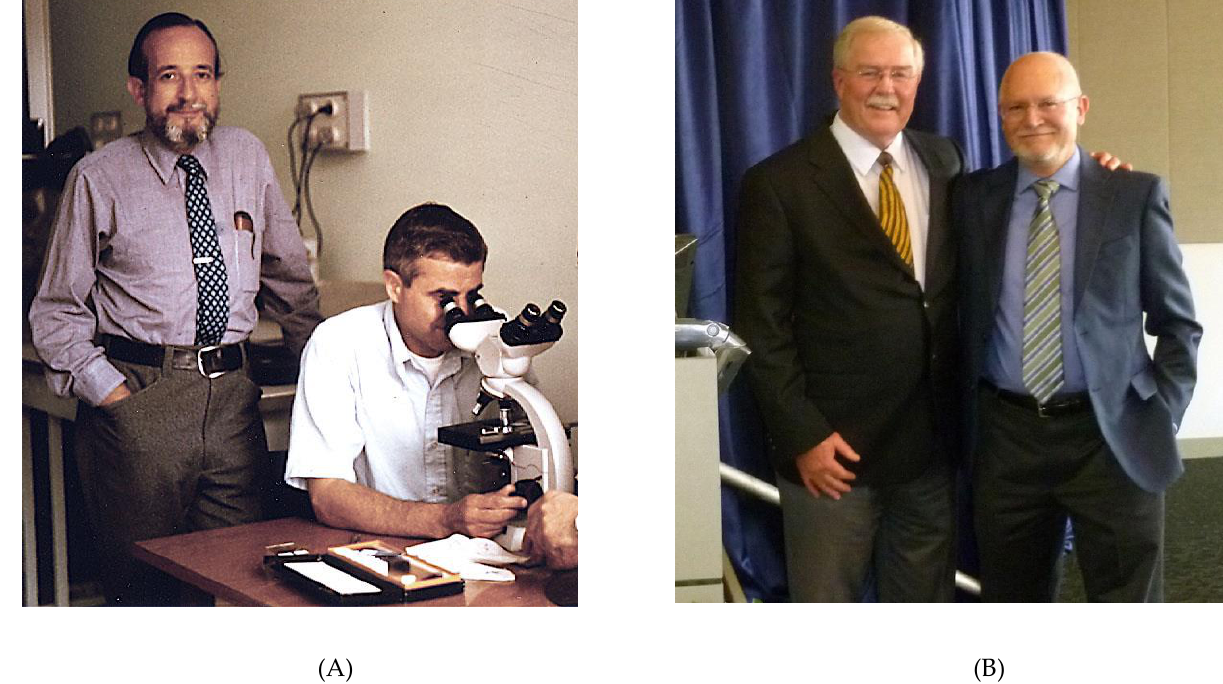
Figure 1. ( A ) Photograph of Dr. Grogan’s mentors, Drs. Ronald Dorfman and Costan Berard (at microscope) discussing a challenging case (1976). ( B ) Drs. Thomas Grogan and Roger Warnke, at the inaugural Warnke Lectureship delivered by Dr. Grogan at the Department of Pathology, Stanford University School of Medicine (2015).